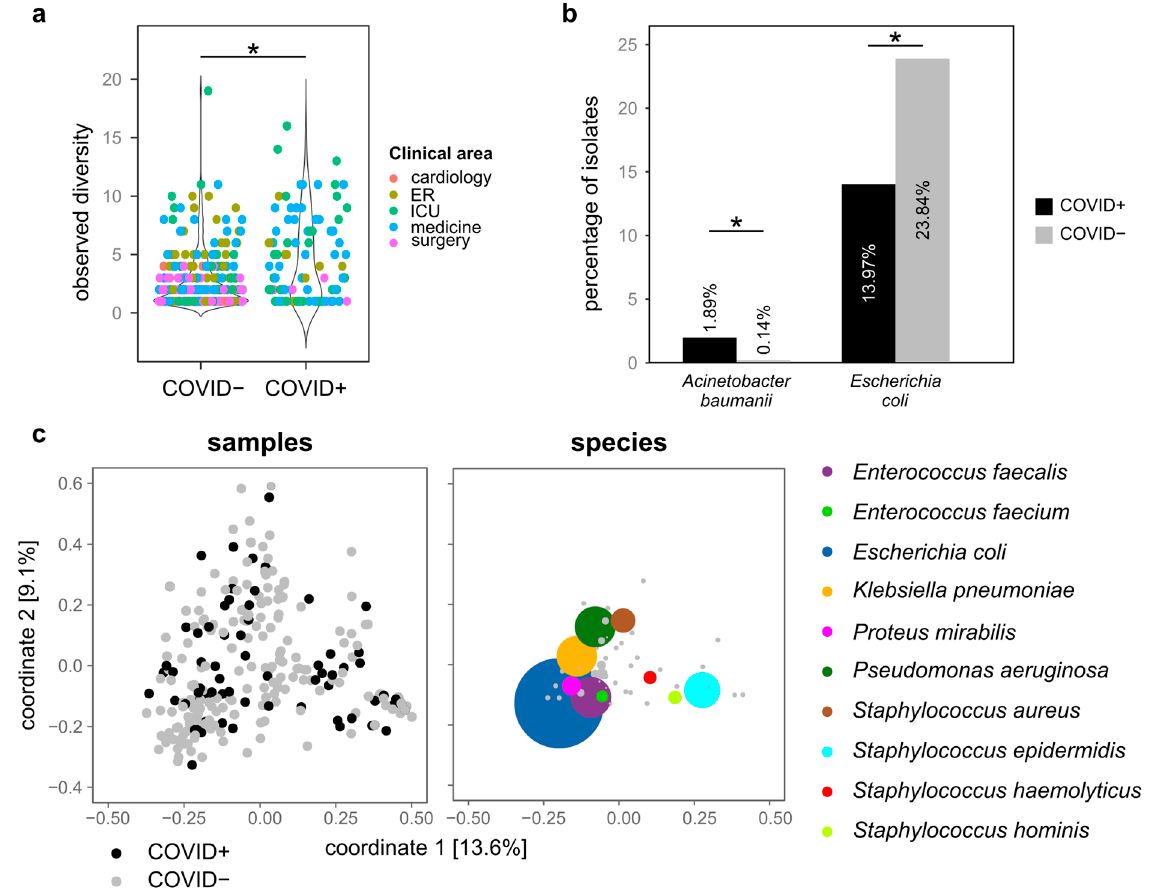
Figure 2. Distribution of bacterial species among patients. ( a ) Observed number of species per patient, grouped according to the COVID-19 status. Each point indicates a different group of strains (grouped as being isolated in the same month and year, from patients hospitalized in the same clinical area and being either COVID+ or COVID − ). ( b ) Species whose abundance significantly differed among COVID+ and COVID − patients. ( c ) First two coordinates of the principal coordinate analysis based on the Jaccard distances calculated among samples grouped as described for panel a. On the left part, the distribution of isolates, on the right part the distribution of the most abundant bacterial species. * = Wilcoxon-Mann-Whitney p value < 0.05.